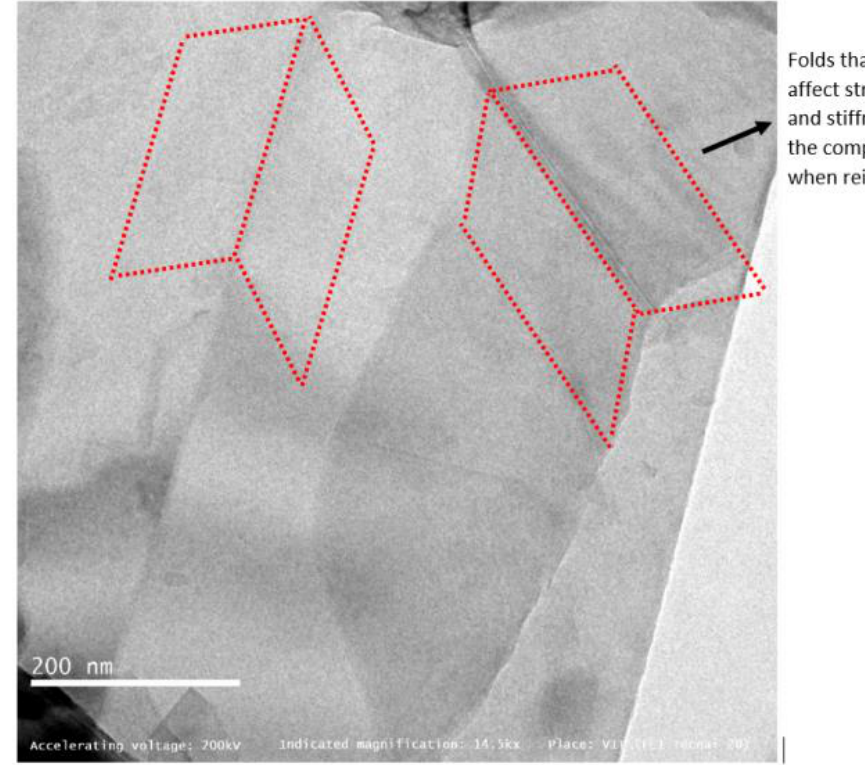
Figure 3. HR-TEM observation of graphene at 2500×.